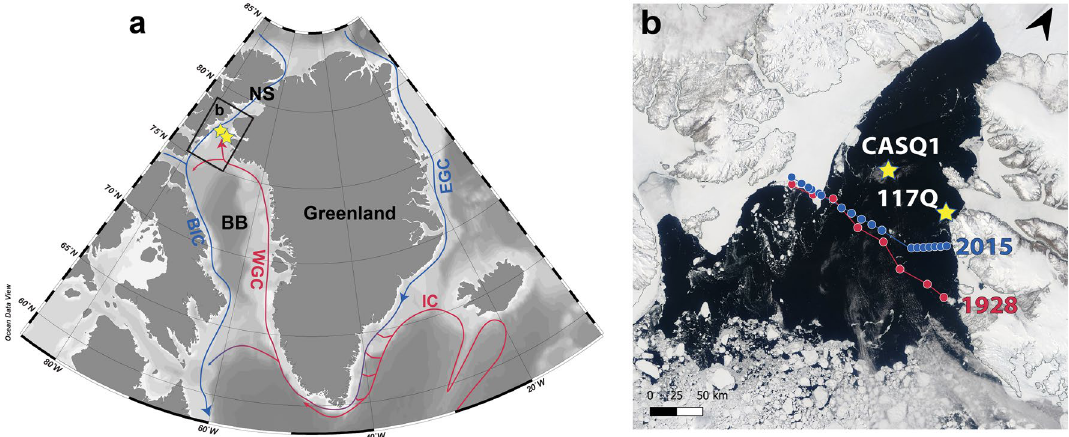
Figure 1. Study area and satellite imagery of the North Water Polynya. ( a ) Geographical location of the North Water Polynya (NOW) and sediment cores (yellow stars) in northernmost Baffin Bay (BB) south of Nares Strait (NS). Regional warm (red) and cold (blue) ocean currents include BIC Baffin Island Current, WGC West Greenland Current, IC Irminger Current, EGC East Greenland Current. Insert ( b ) Satellite image (MODIS; NASA worldview) of the NOW region on the 26 May 2008 and central (CASQ1) and peripheral (117Q) core sites and the location of the CTD transects from 1928 (red) and 2015 (blue) in Fig.